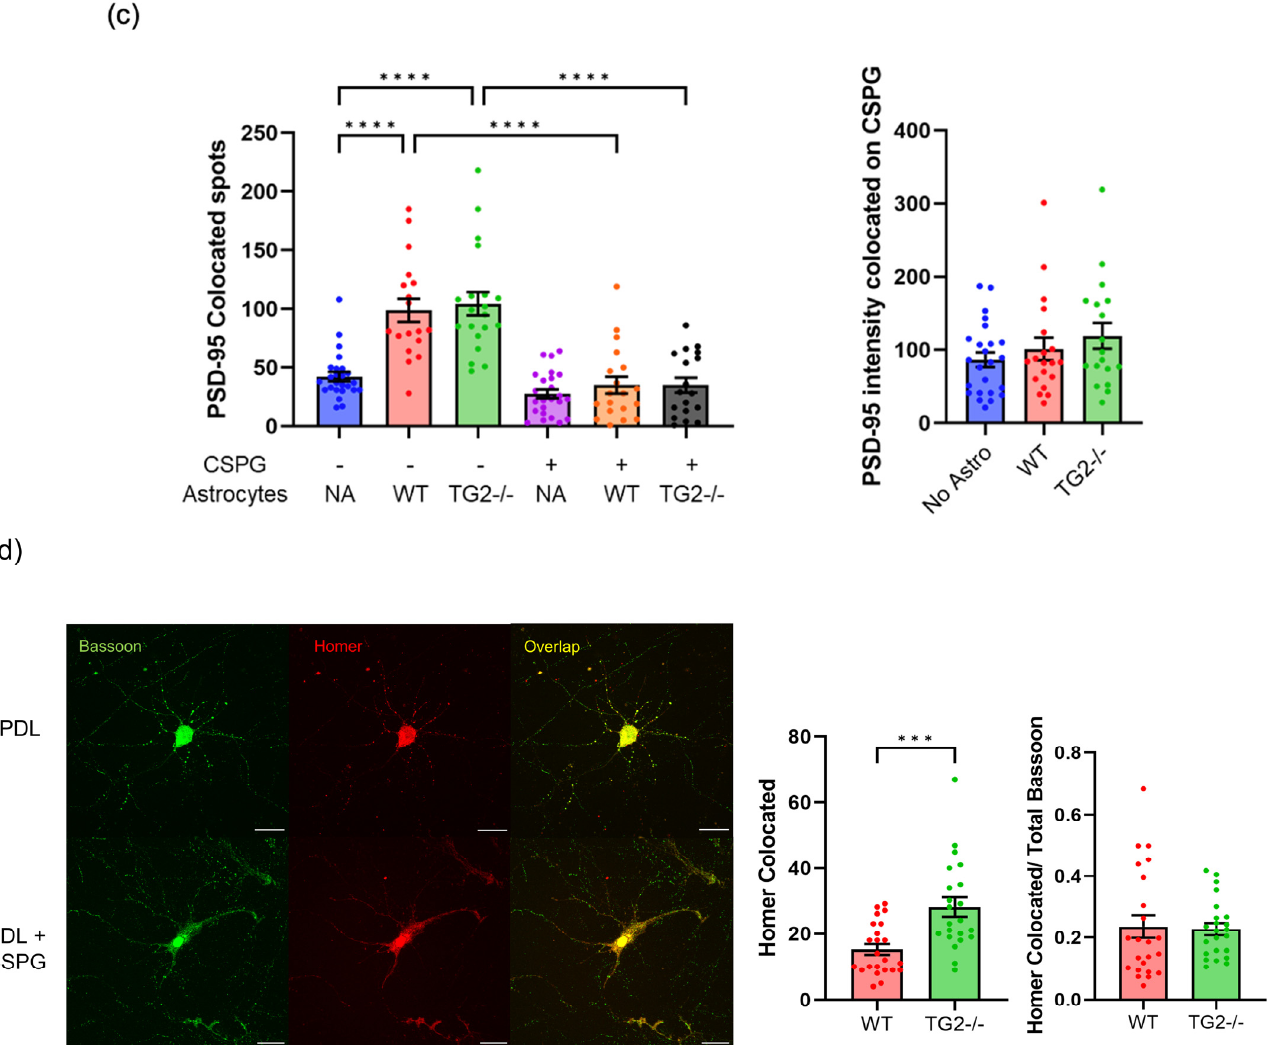
Figure 2. Astrocytes facilitate synapse formation among neurons on a permissive, but not inhibitory matrix, independent of the presence of TG2. ( a ) Images of PSD95/Synaptophysin immunostaining of neurons grown on poly-D-lysine (PDL) with no astrocytes (NA) or with WT or TG2 − / − astrocytes (scale bar = 20 µm), ( b ) Images of PSD95/synaptophysin immunostaining of neurons grown on CSPG inhibitory matrix without astrocytes or with WT or TG2 − / − astrocytes (scale bar = 20 µm), ( c ) Quanti fi cation of neuronal synapses approximated by PSD95 puncta collocated with Synaptophysin puncta exclusively in neurites; intensity-based identi fi cation of spots was used to more accurately capture puncta in CSPG conditions (18–24 neurons per condition from two independent biological replicates, Two-way ANOVA, **** p < 0.0001), ( d ) Representative images of Homer/Bassoon immunostaining for neurons grown on PDL and PDL+CSPG (scale bar = 20 µ m), and quantification of synapses on PDL approximated by Homer puncta collocated with Bassoon puncta exclusively in neurites (22–23 neurons per condition from two independent biological replicates, unpaired t -test, *** p < 0.001).